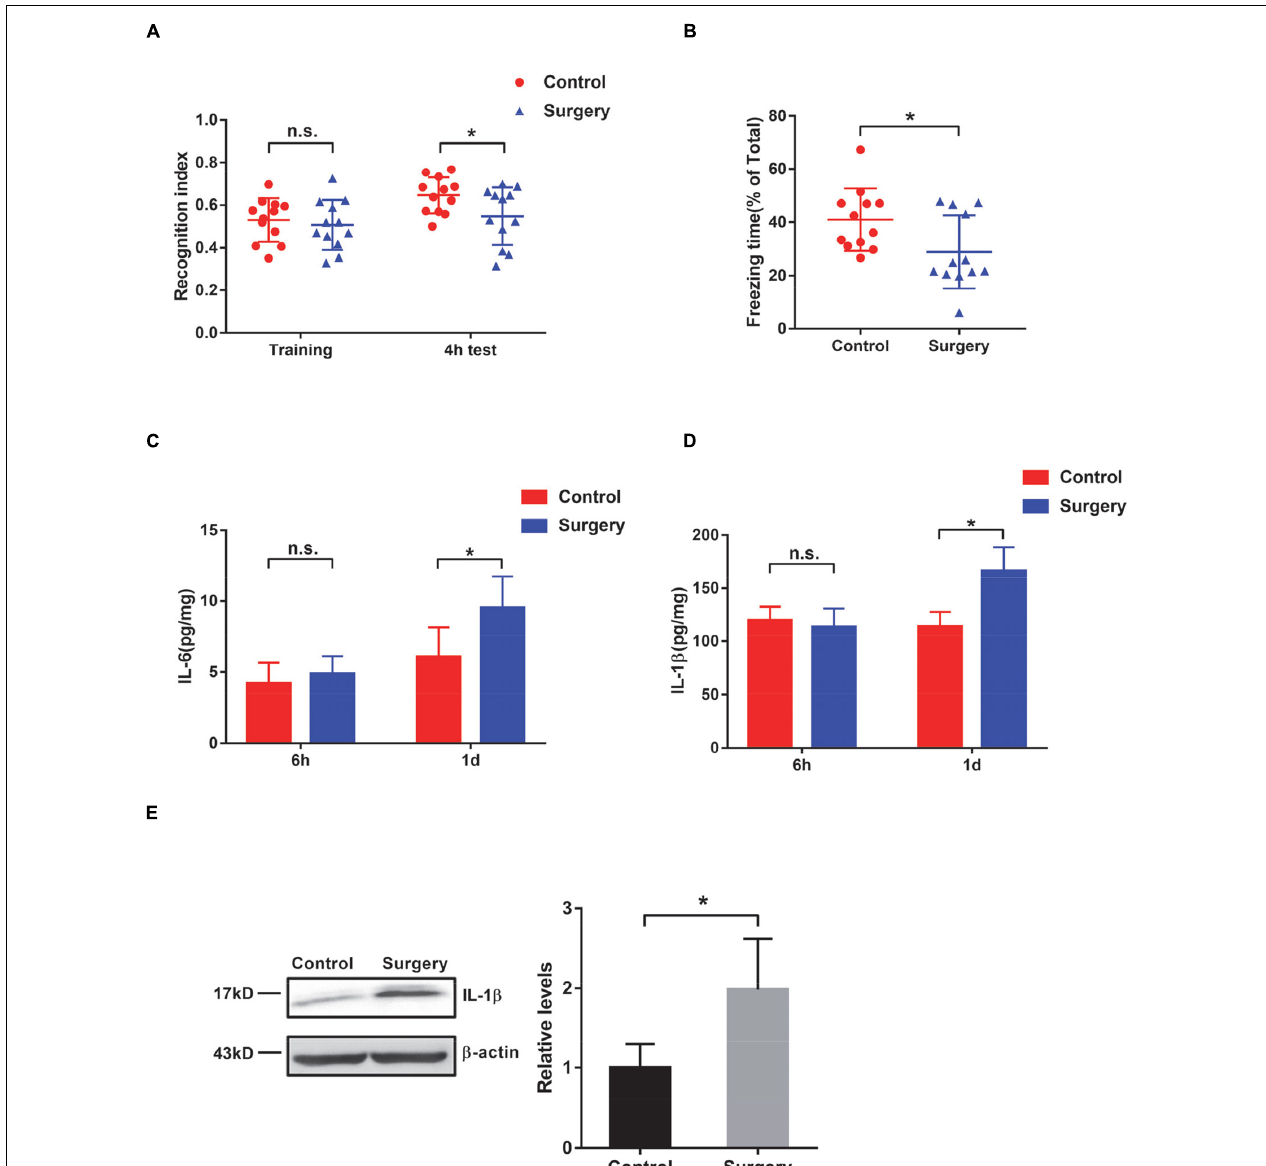
FIGURE 1 | Evaluation of cognition and neuroinflammation in mice after tibial surgery. (A) Contextual memory was evaluated by the novel object recognition (NOR) task. The recognition index was calculated for control and surgery mice at the training phase and 4 h after the training ( n = 12 per group). (B) Contextual memory was evaluated by the fear conditioning task. Freezing time was recorded, and the ratio of freezing time to the total testing time was calculated ( n = 12 per group). (C–E) Wild-type (WT) mice were subjected to tibial surgery, and hippocampal tissues were collected at 6 h or 1 day post-surgery. Levels of IL-6 (C) and IL-1 β (D) in the hippocampus were determined by an ELISA-based approach ( n = 6–9 per group). Levels of IL-1 β in the hippocampus were also determined by immunoblotting and densiometric analysis (E) ( n = 4 per group). In this and subsequent figures, h represents hours and d represents days. * P < 0.05 by independent samples Student’s t -test; n.s. not significant; error bars denote the standard error of mean